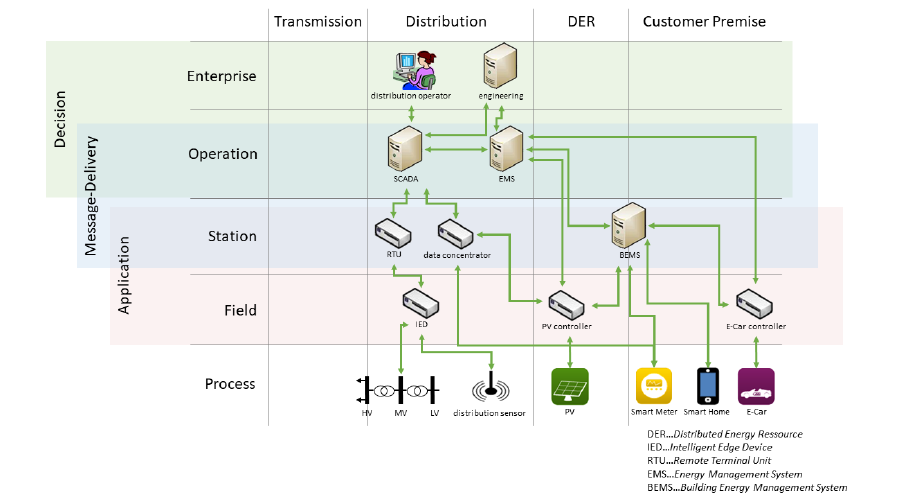
Figure 7. Mapping of subsystems to the smart grid architecture model